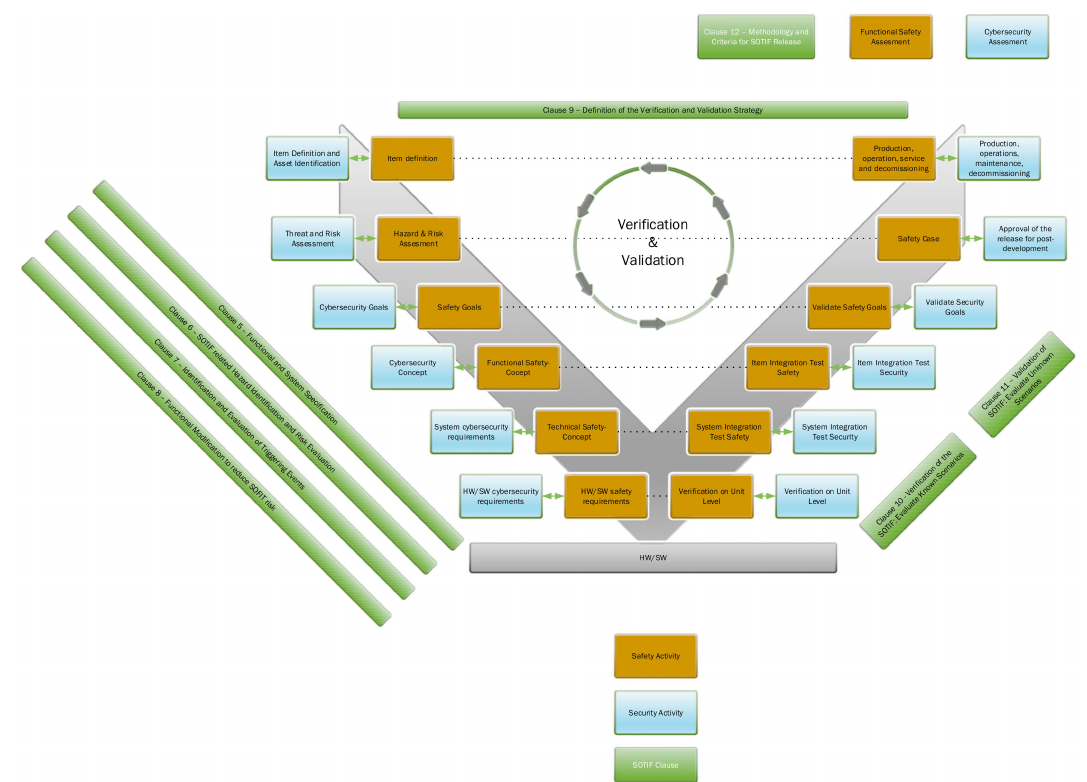
Figure 8. Combined V-model for autonomous cyber–physical